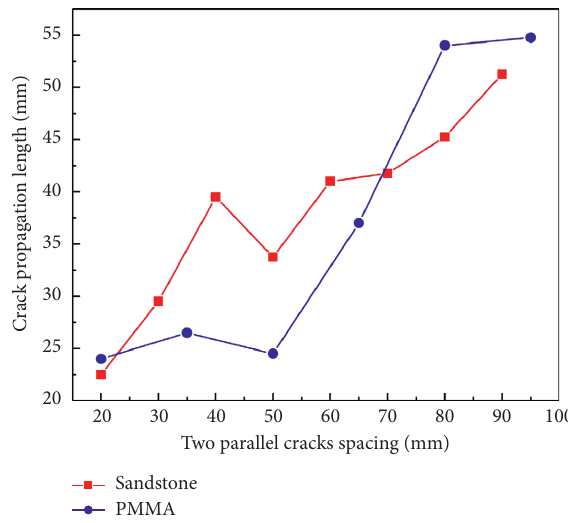
Figure 8: Main crack propagation length versus the spacing of parallel